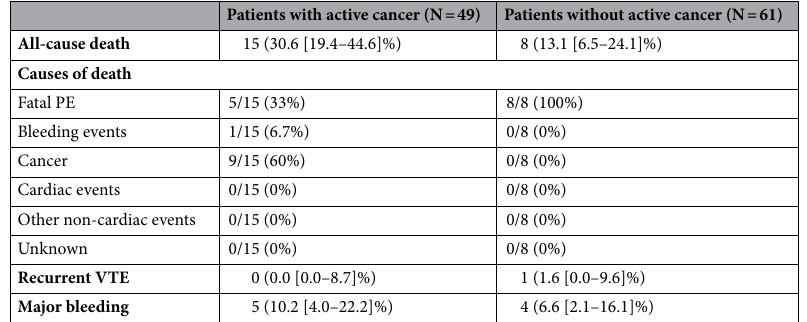
Table 5. Clinical outcomes at 90 days after first recurrent VTE events during anticoagulation therapy comparing patients with and without active cancer. The 90-day clinical outcomes after the first recurrent VTE are presented as the number of events and incidences with 95% confidence intervals. Death was judged to be due to PE (fatal PE), if it was confirmed by autopsy or if death followed a clinically severe PE after first recurrent PE events. Death was judged to be bleeding-related, if it followed an intracranial haemorrhage or a bleeding episode leading to hemodynamic deterioration. Death from end-stage cancer without a specific cause of death was regarded as of cancer origin. Death was judged to be due to cardiac events, if it followed acute myocardial infarction, heart failure, or ventricular arrhythmia. VTE venous thromboembolism, PE pulmonary